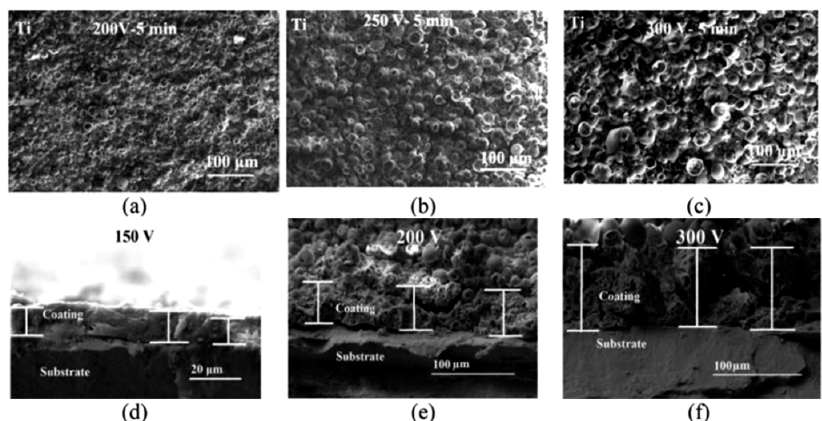
Figure 2. SEM micrographs of the wollastonite-calcium phosphate (W-CaP) coatings on Ti ( a – c ) and SEM micrographs of the cross-sectional W-CaP coatings on Ti ( d – f ) produced under different voltages [29].